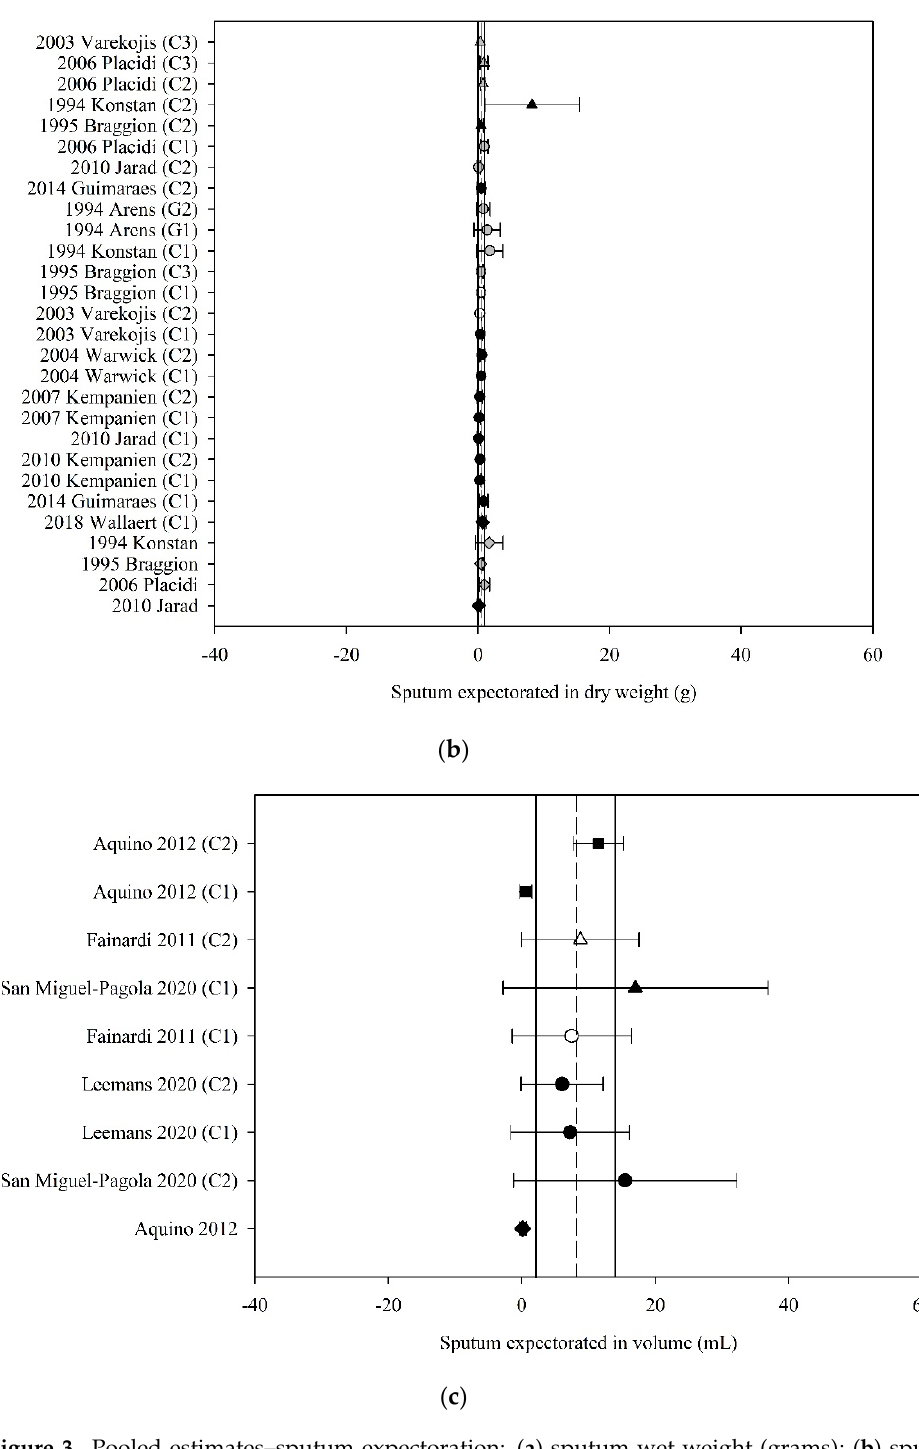
Figure 3. Pooled estimates–sputum expectoration: ( a ) sputum wet weight (grams); ( b ) sputum dry weight (grams); ( c ) sputum volume (millilitres). C_ = crossover intervention, G_ = RCT group, g = grams, ■ = positive pressure device (PPD), ▲ = positive expiratory pressure device (PEP), ● = other techniques (OT), ♦ = cough alone (C), closed symbol = stable population, open symbol = acute population, grey symbol = mixed population or nil info, dashed line = pooled estimate, solid vertical line = 95% CI, all individual data presented as mean ± SD.